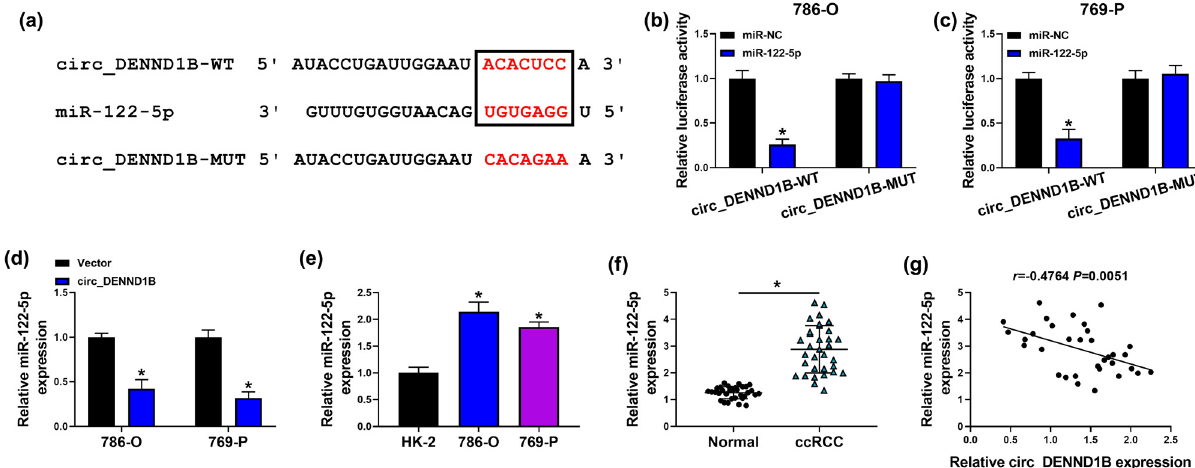
Figure 3: miR - 122 - 5p was a target of circ_DENND1B. ( a ) The binding sites of circ_DENND1B to miR - 122 - 5p. ( b and c ) Dual - luciferase reporter assays were performed to con fi rm the association between circ_DENND1B and miR - 122 - 5p. ( d – f ) qRT - PCR detected the expression of miR - 122 - 5p. ( g ) Pearson ’ s correlation analysis. * P <